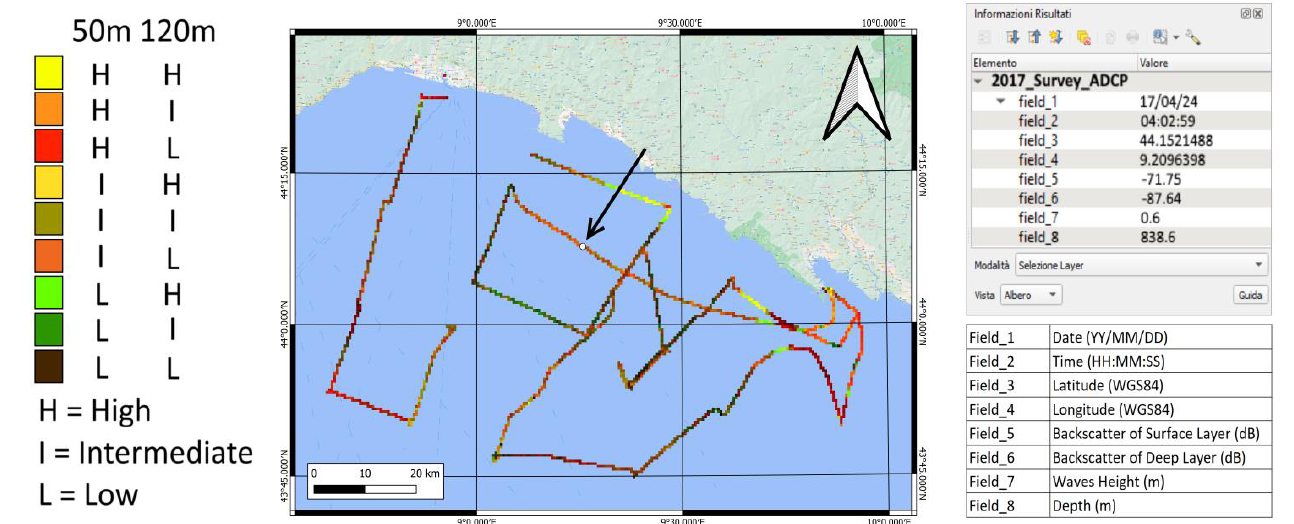
Figure 11. Selection of a point on false color representation map (Figure 7a) along with the panel with the correspondent values of each layer (Field_n). The caption with the associated parameters is reported below the panel.